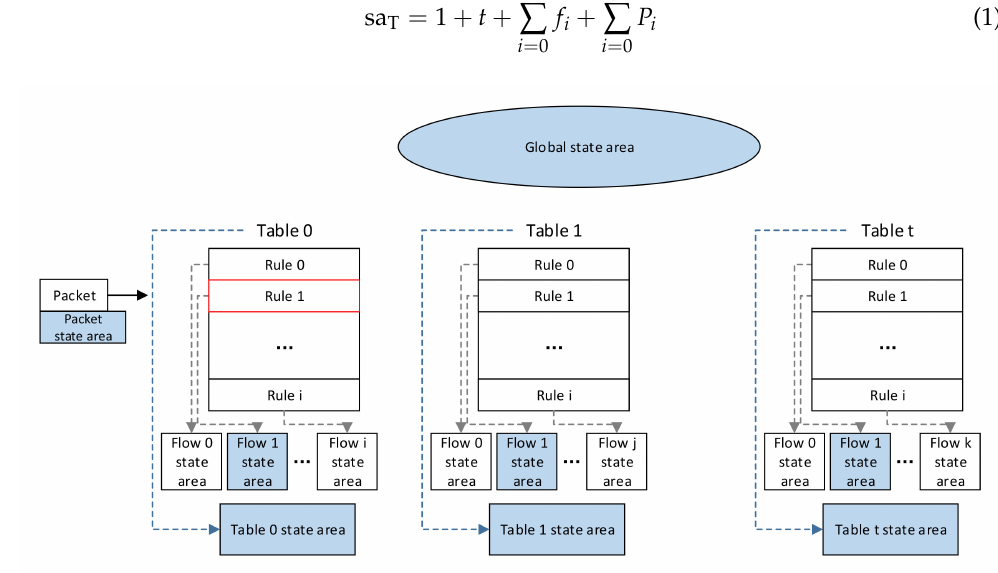
Figure 4. MSSA associate with the multilevel match–action